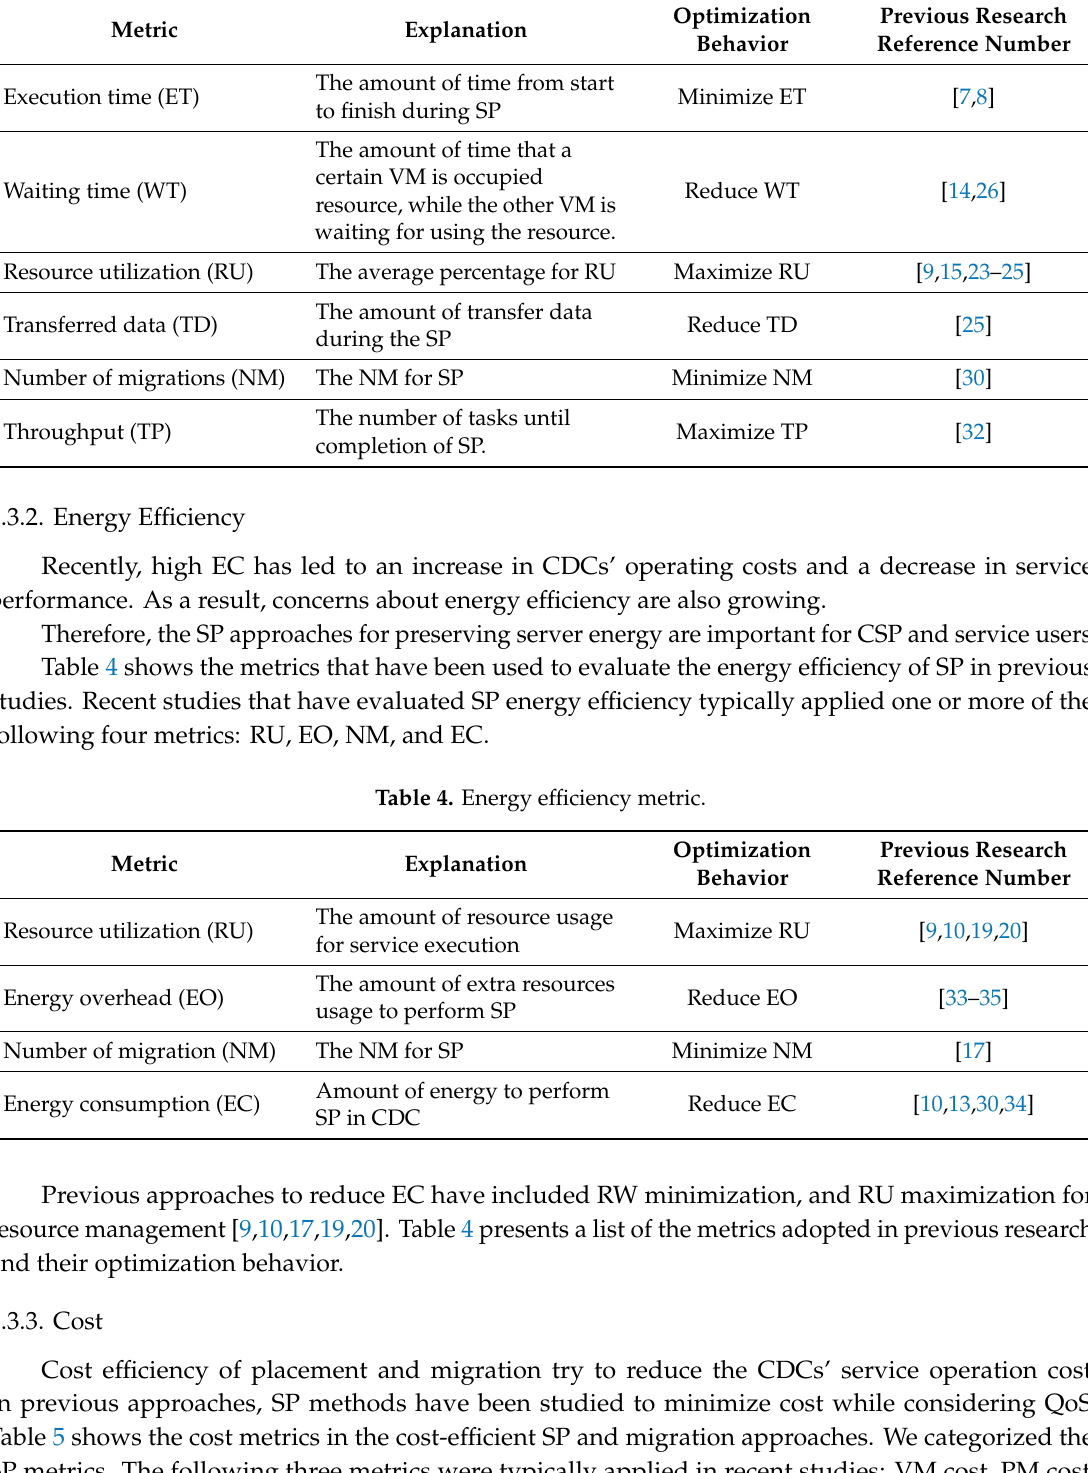
Table 3. Performance metric.